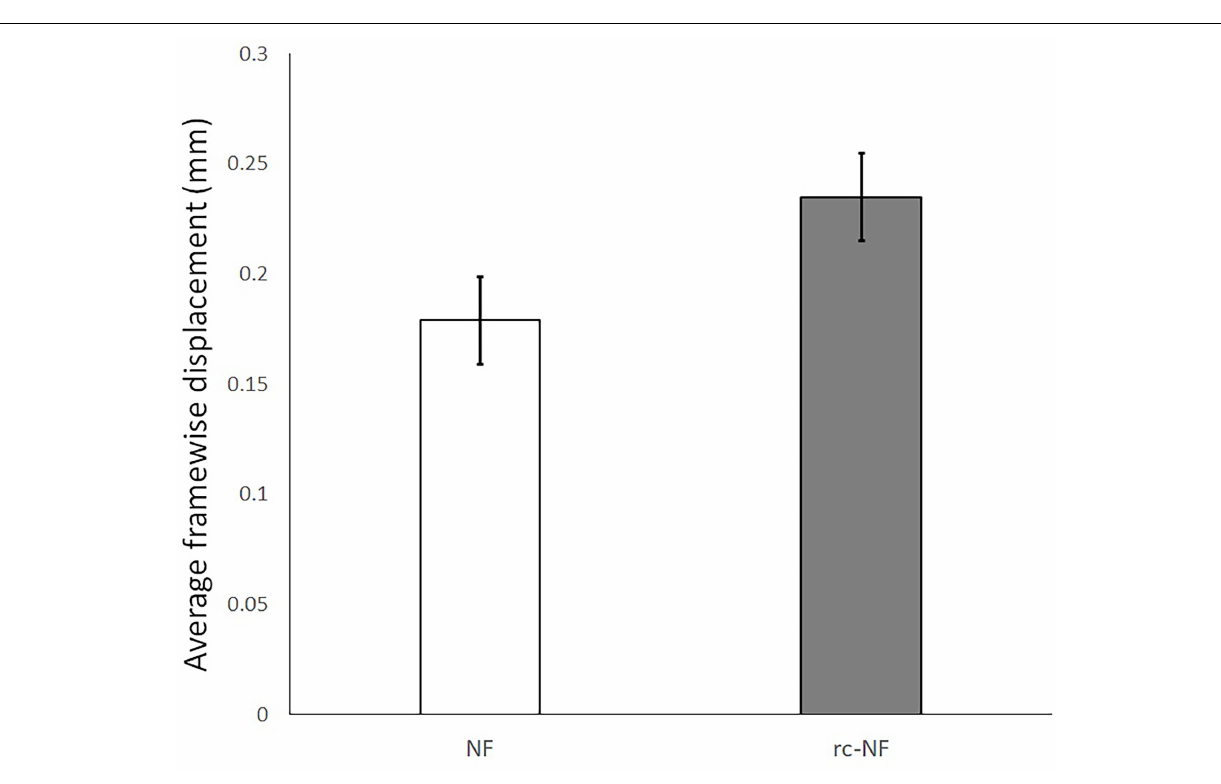
Frontiers in Neuroscience |